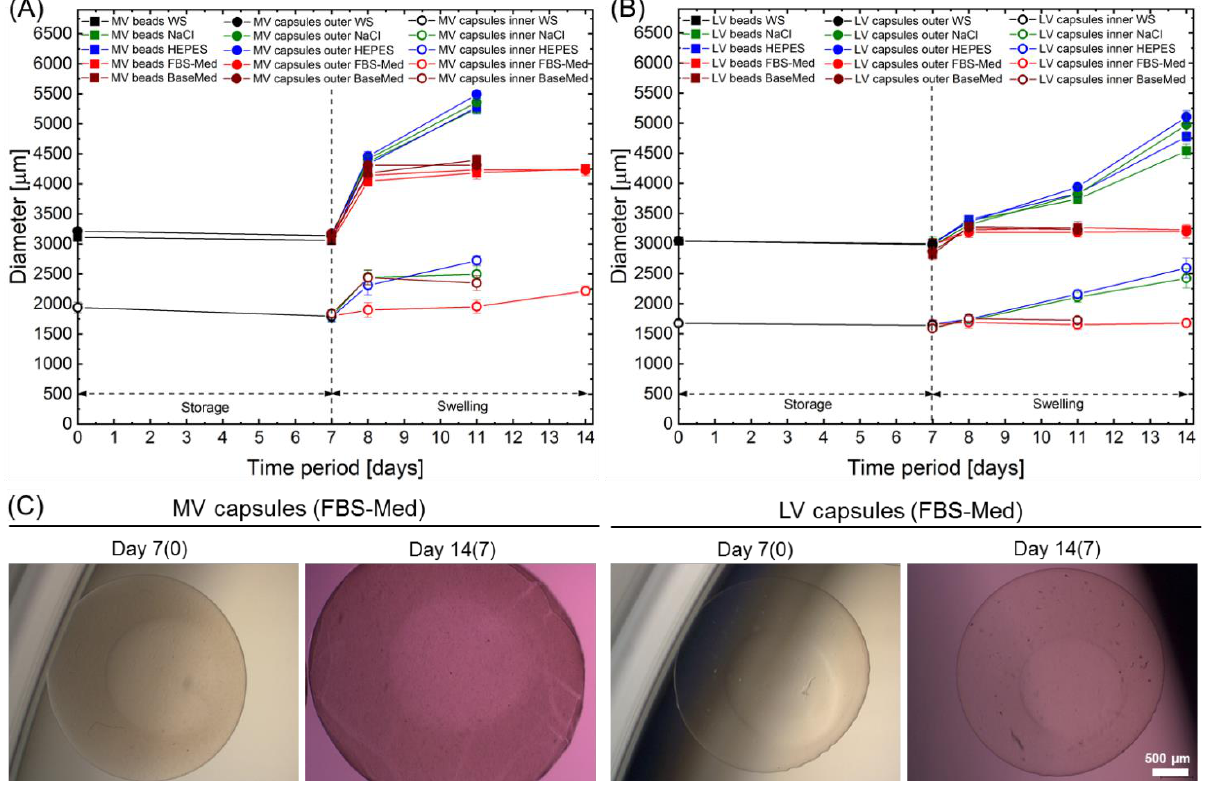
Figure 3. Change in outer (solid beads and core-shell capsules) and inner core (only core-shell capsules) diameters during storage in washing solution (WS) and upon incubation in NaCl and HEPES solutions, fetal bovine serum (FBS)-containing (FBS-Med) and FBS-free (BaseMed) basal medium in the course of further 7 days. ( A ) Solid beads and core-shell capsules produced from 2% medium viscosity (MV) alginate; ( B ) solid beads and core-shell capsules produced from 2% LV alginate. ( n = 18). Filled squares show solid beads, cycles—core-shell capsules with outer (filled cycles) and inner core diameters (open cycles), different colours correspond to different solutions (black—WS, green—NaCl, blue—HEPES, red—FBS-containing medium, brown—FBS-free medium); ( C ) Bright-field photographs of MV and LV core-shell capsules on day 7 and 14 (days 0 and 7 of swelling) in cell culture medium. Scale bars are 500 µm.